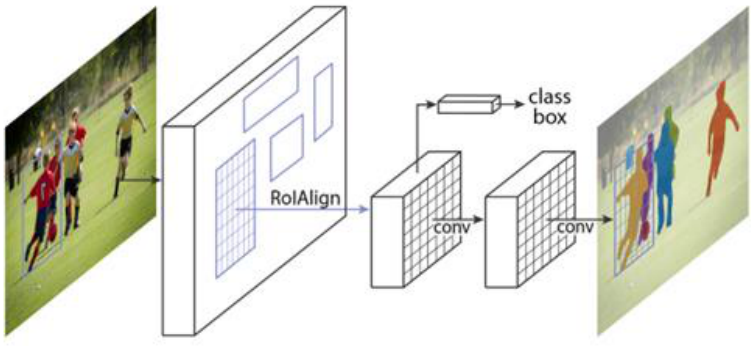
Figure 11. Illustration of the Mask-RCNN principal for instance segmentation [26].